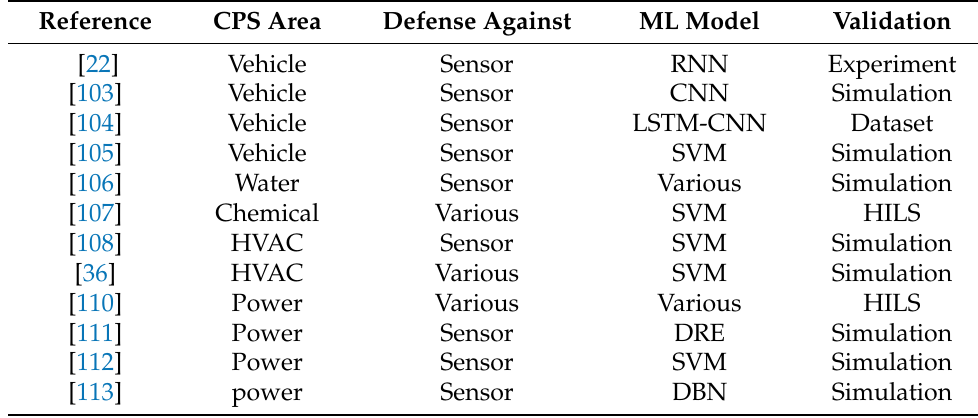
Table 1. Summary of ML-based anomaly detection methods in the physical